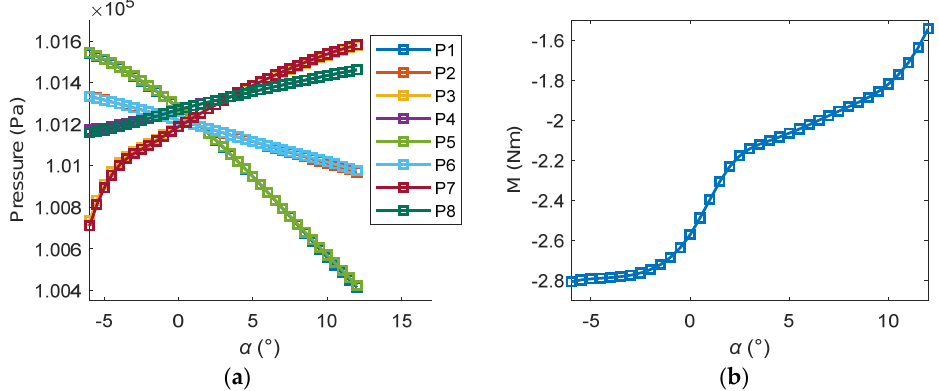
Figure 3. The computational data (sampling rate of 0.5°): ( a ) eight sensors’ measurements; ( b ) target data of pitching moments.